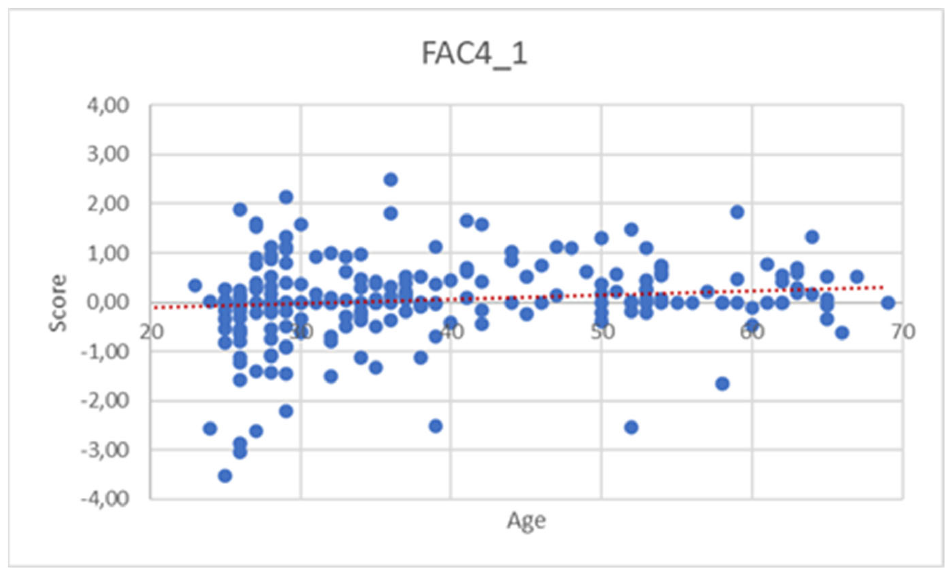
Figure A13. This is a figure. Schemes follow the same formatting. Table A1. Respondent characteristics for company locations.